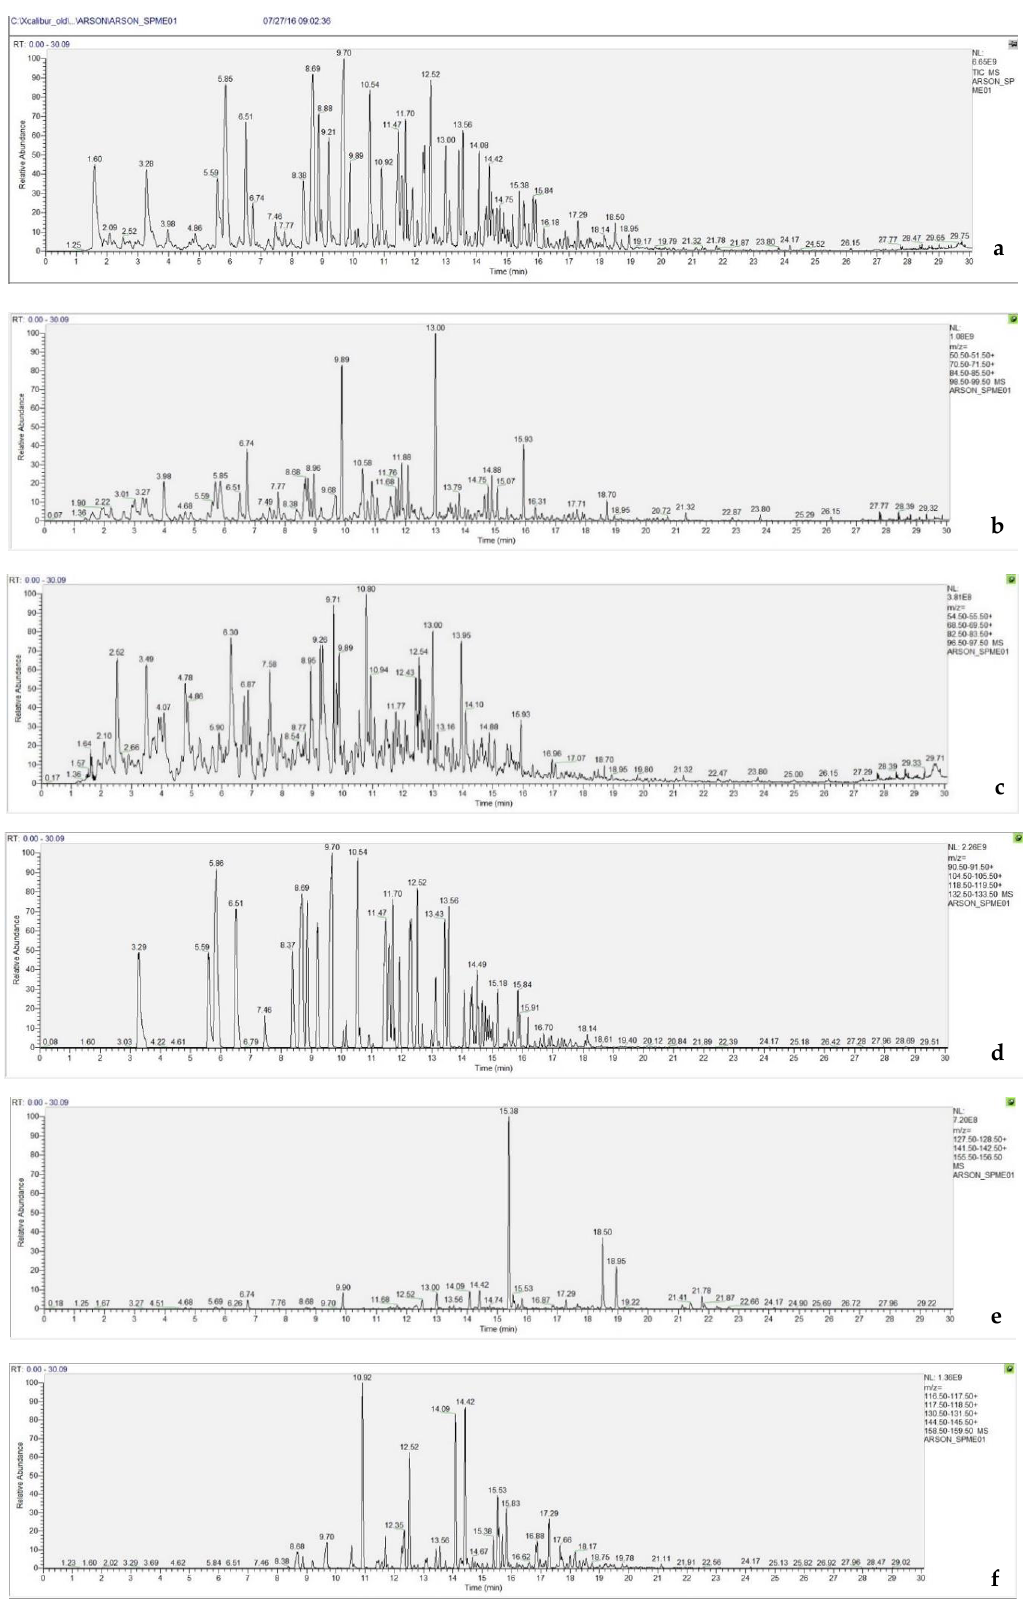
Figure 1. GC-MS extracted ion data related to neat gasoline. ( a ) Total ion chromatogram; ( b ) extracted alkane profile; ( c ) extracted cycloalkanes and alkenes profile; ( d ) aromatics (alkylbenzenes) profile; ( e ) extracted polynuclear aromatics profile; ( f ) extracted indane